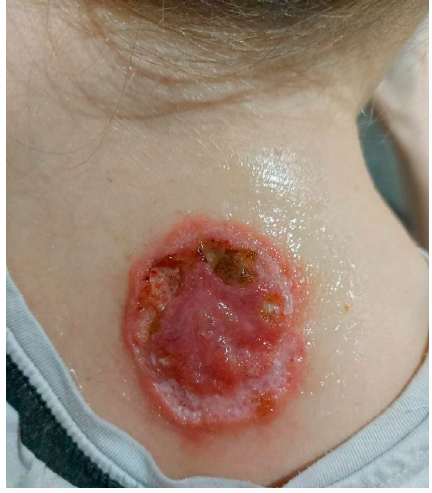
Figure 5. On admission in the Department of Dermatology, a single raised serpiginous erythematous-brown plaque (5 × 6 cm) with small ulcerations and the central scarring on the right scapula. On the scalp in the parietal area, erythema covered with greasy yellowish scales was observed, with slightly swollen skin and subcutaneous tissue (Figure 6).